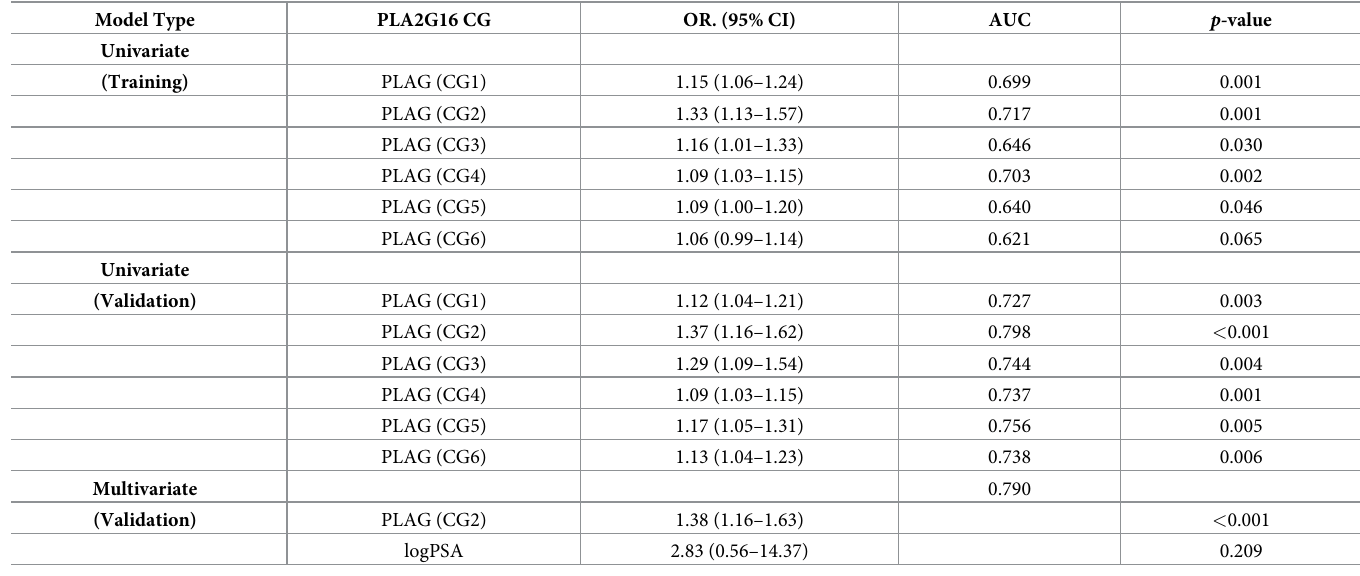
Table 2. Odds of prostate cancer with PLA2G16 methylation alone or with clinical factors in